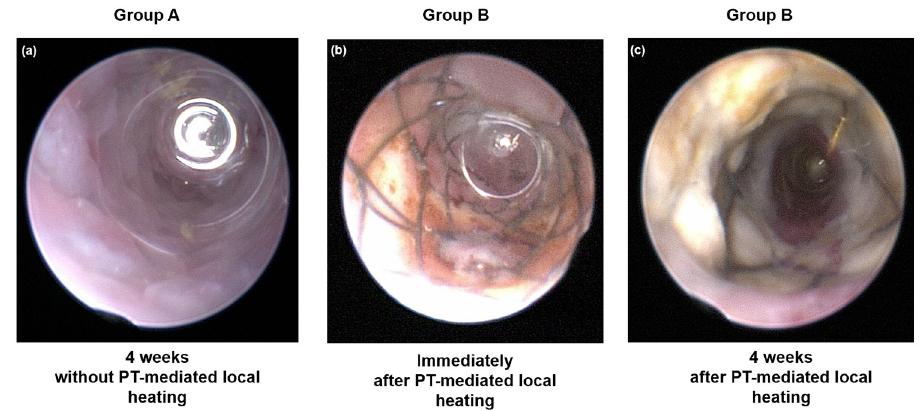
Fig 3. In vivo endoscopic images obtained (a) 4 weeks after stent placement without local heating in Group A, (b) immediately after local heating in Group B, and (c) 4 weeks after stent placement with local heating in Group B. PT: Photothermal.